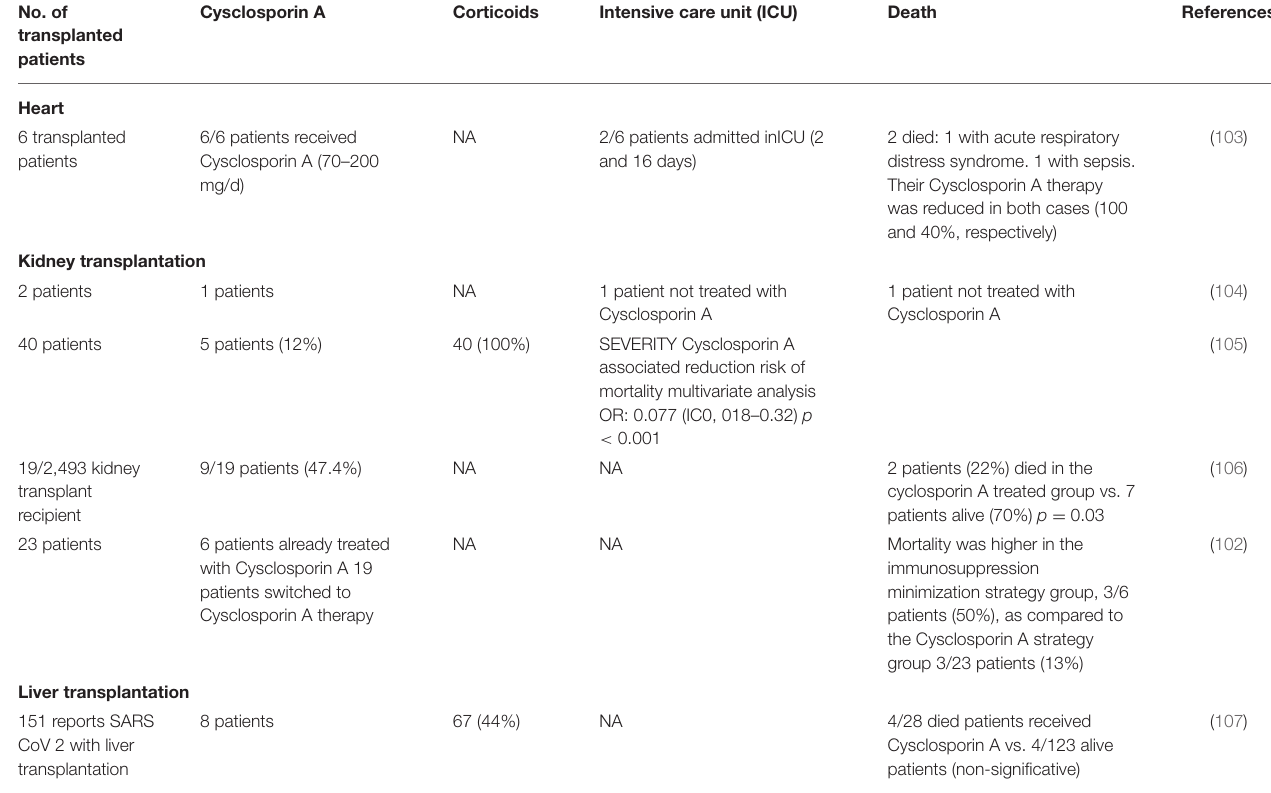
TABLE 3 | Cyclosporin A based treatment in transplanted patients. No. of